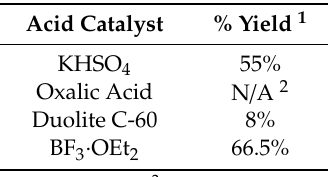
Scheme 7. Synthesis of vitamin K 1 using Friedel-Crafts alkylation with different acid catalysts [54].